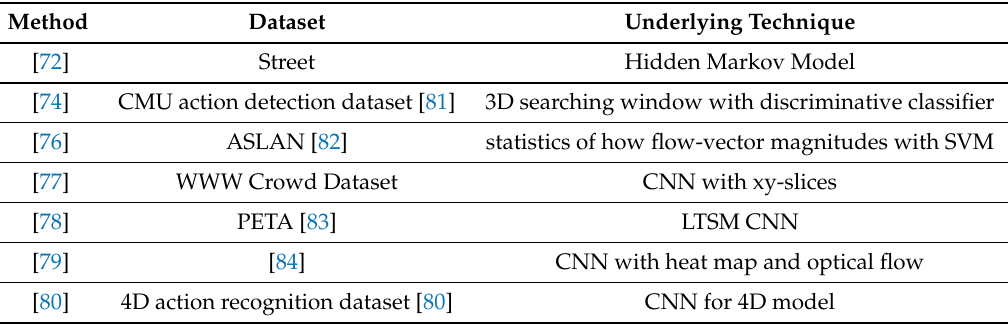
Table 2. Comparison of state-of-the-art crowd action recognation algorithms.